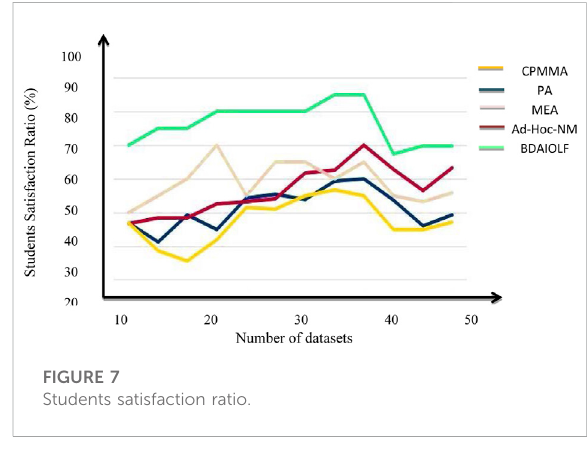
FIGURE 7 Students satisfaction ratio.